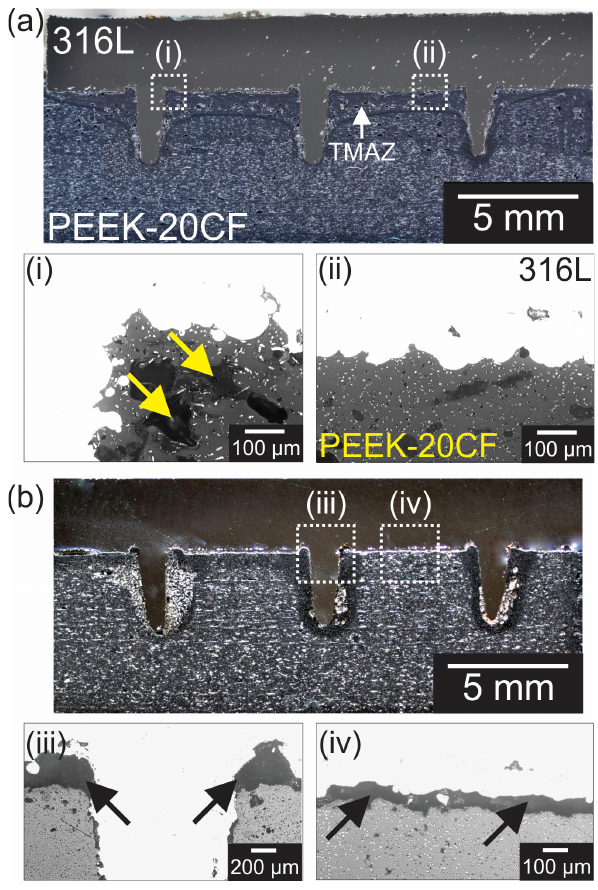
Figure 6. Cross-sectional view of optimized 316L/PEEK-20CF hybrid joints, with detailed images of the metal-composite interface for ( a ) horizontal and ( b ) vertical U-Joints. ( i – iv ) show selected regions from both conditions.